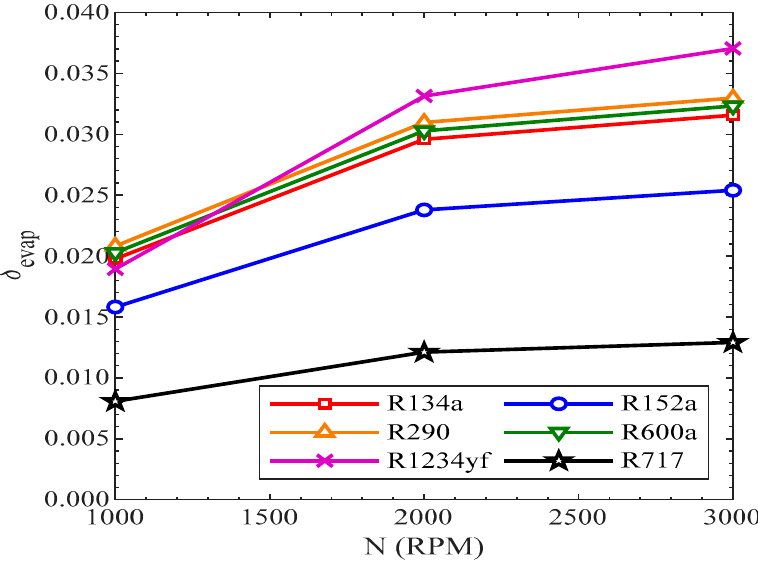
Figure 21. Efficiency defect evaporator vs. compressor speed .